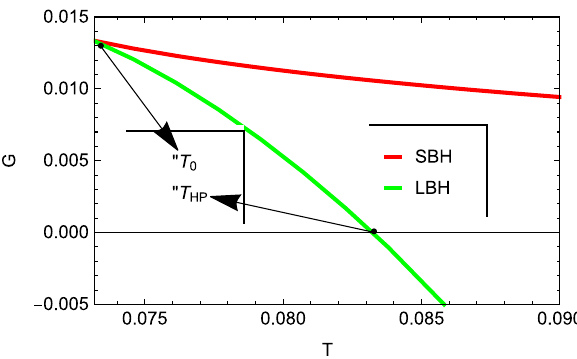
mum function, below which no BH exists [40]. After calcu- lating r + in terms of T from Eq. (40), we obtain two event and r neg which correspond to the large and small horizons r pos BHs respectively. In Figs. 9 and 10, we express r + in terms of T for increasing values of charge Q and coupling con- stant ζ for P = 0 . 04. In both figures, the critical points are represents by intersections (LBH and SBH) of dashed and which yields mini- solid curves in Fig. 9. Similarly in Fig. 10, the intersection